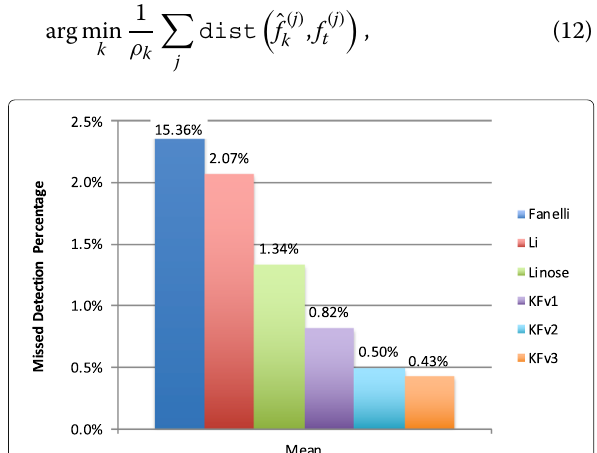
Fig. 9 Mean of the results on the ICT dataset. Percentage of missed